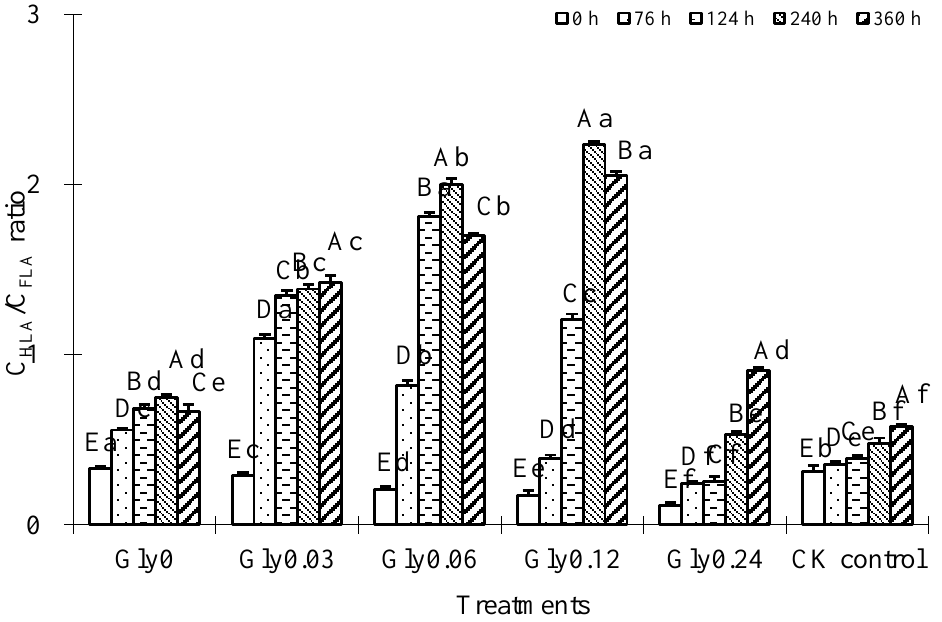
Figure 4. Effects of the glycine with different concentrations in the Maillard precursors on the C HLA /C FLA ratio of the dark-brown residue. Note: Different capital letters indicated significant differences among the different reaction times within the same treatment ( p < 0.05); Different lower-case letters indicated significant differences among the different treatments under the same reaction time ( p < 0.05). The FTIR spectra of the dark-brown residue treated with glycine at different con- centrations are shown in Figure 5. The broad peak at 3419~3435 cm − 1 could not only represent the -OH stretching vibration of δ -MnO 2 or its interlayer water molecule but also the H–bonded O–H stretching vibration of hydroxyl groups from alcohols, phenols and organic acids and H-bonded N–H groups [19]. The bands of 2922 cm − 1 and 2850 cm − 1 were ascribed to the aliphatic C–H stretching of CH 3 /CH 2 groups [20], which were only